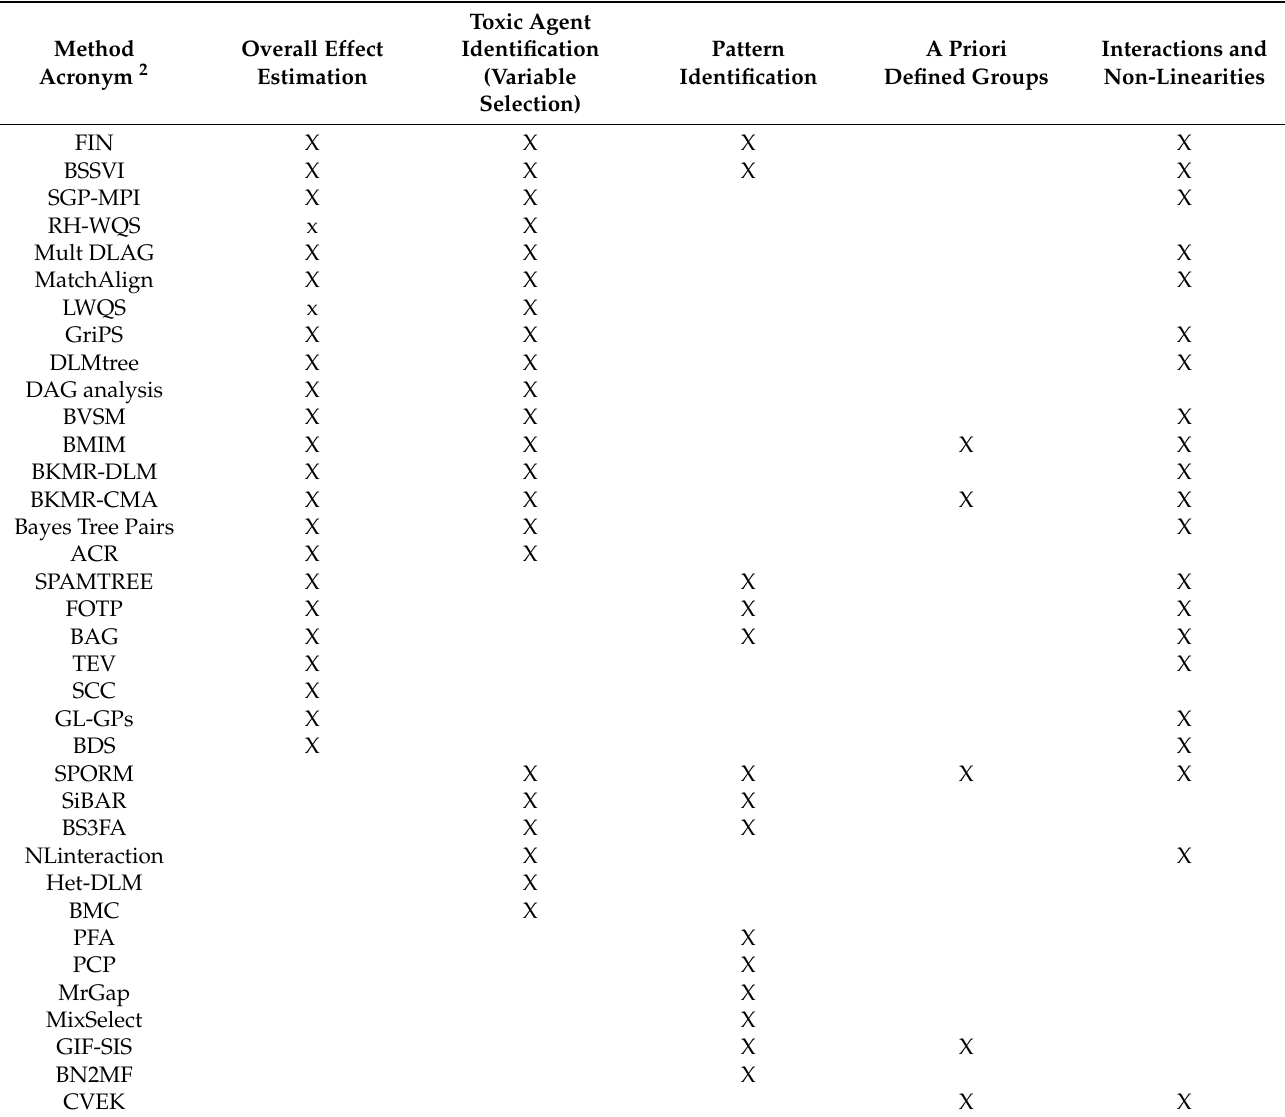
Table 3. PRIME Methods by Research Question 1 .